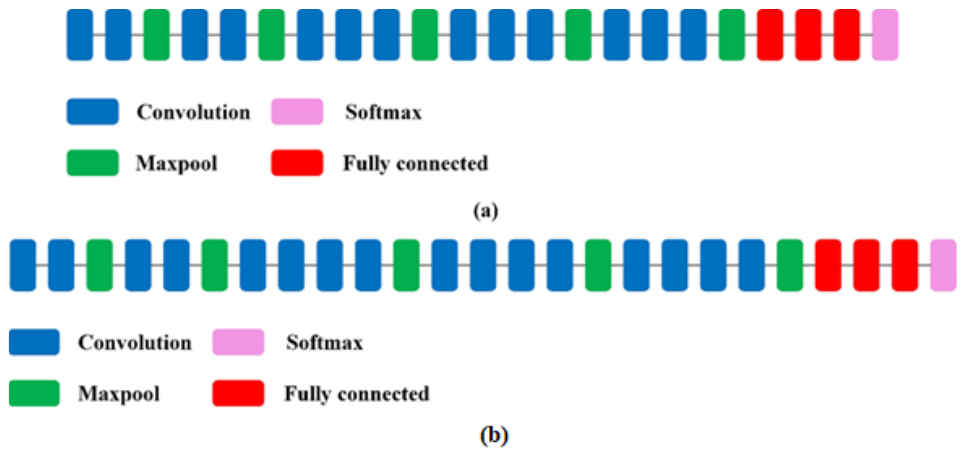
Figure 4. Structure of the VGG16 ( a ) and VGG19 ( b ) network models [47].